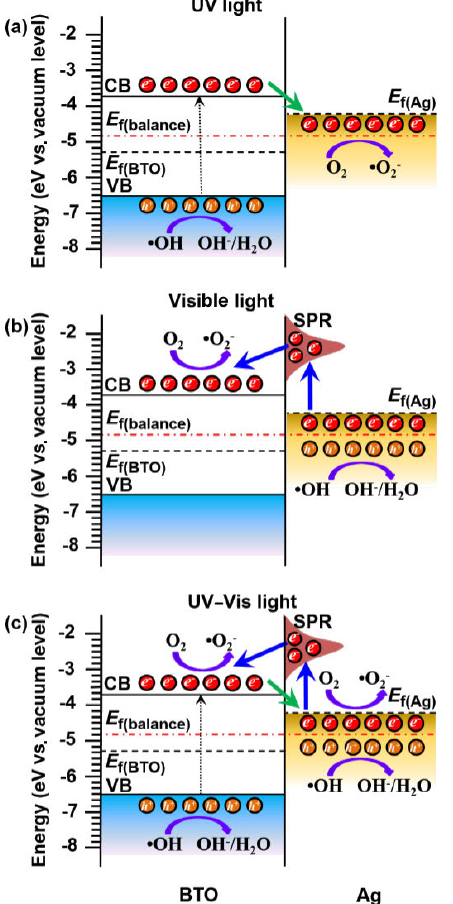
Fig. 10 Mechanism of CT for the Ag/BTO system under different light sources with approximate energy levels on the vacuum level: (a) UV light, (b) visible light, and (c) UV–Vis